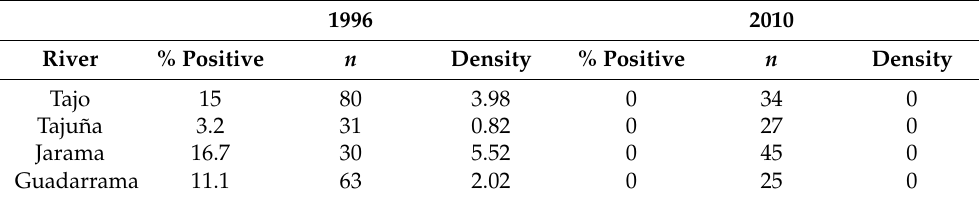
Table 4. Percentage of sampling points with presence (% positive) and density (individuals/10 ha) of jackdaws during the breeding season in riverside forests of the Tajo, Tajuña, Jarama and Manzanares Rivers, Madrid, central Spain (Zone 1, see Figure 1). Data refer to sampling points selected at random in 1996 [63] and 2010 (this